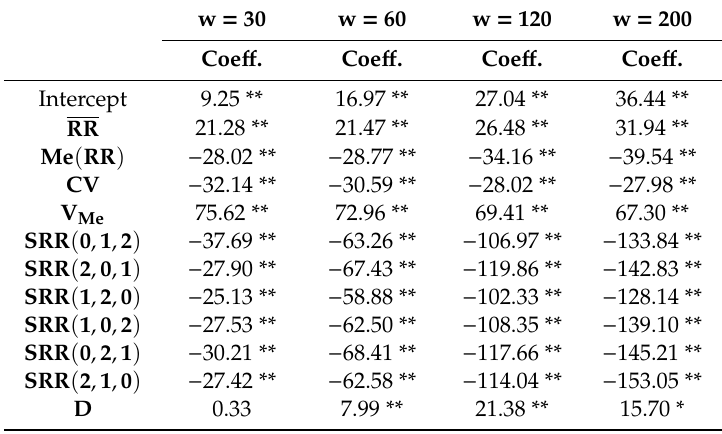
Table A2. Coe ffi cients of the logistic model for the probability of AF for PhysioNet MIT-BIH Atrial Fibrillation database. w = 30 w = 60 Coe ff . Coe ff . Coe ff